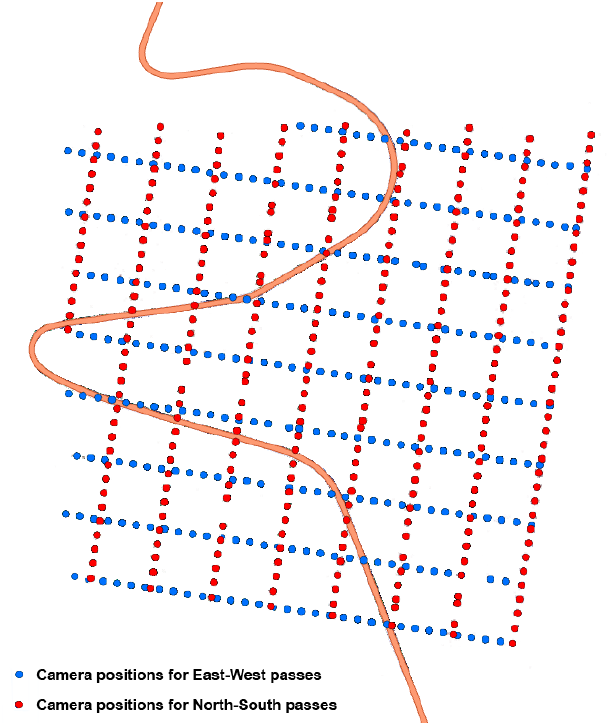
Figure 2. UAV positions during passes in data acquisition. Table 3. Technical specifications of flight